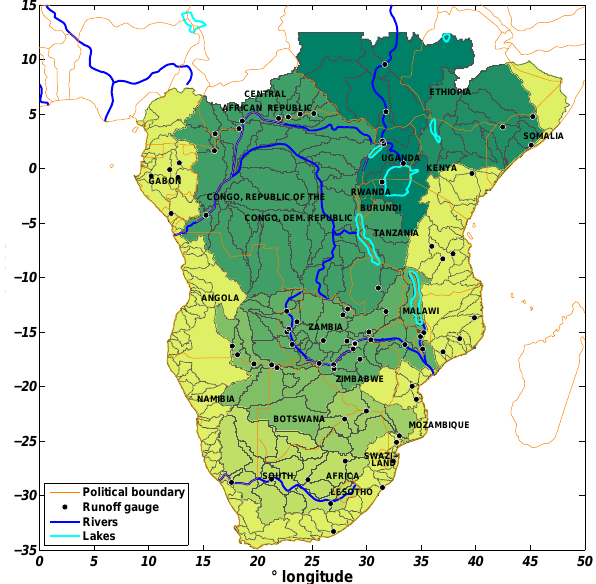
Fig. 2. The Lumped Elementary Watershed model for Southern Africa as being used in this study. The grey lines represent the delineations of sub-catchments. Large rivers and lakes are indicated in respectively dark and light blue. The major river basins selected for this model are shown in a color gradient from dark-green to yellow. The black dots indicate locations of runoff gauges, from which monthly stream flow records are available and have been used for